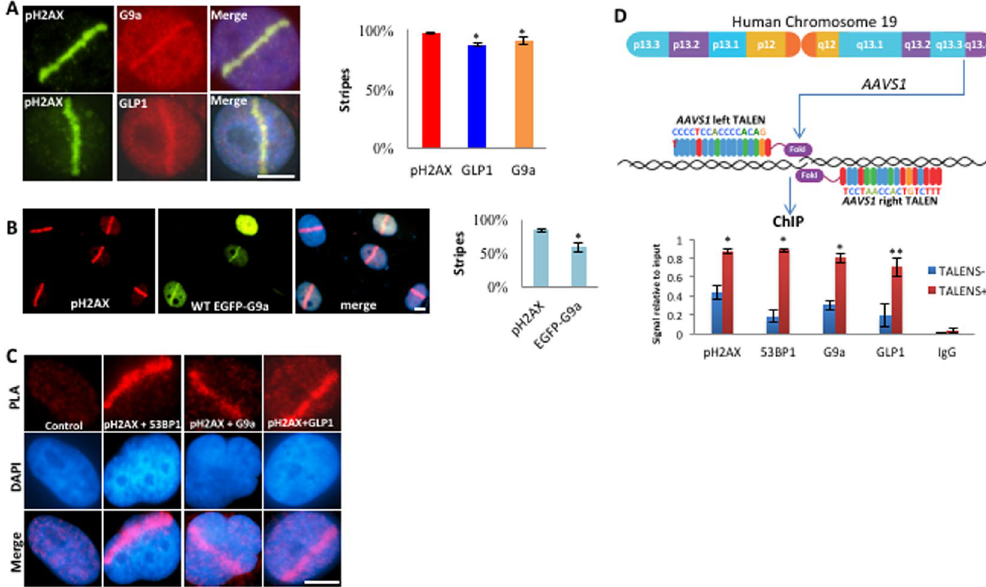
Figure 1. G9a and GLP1 accumulate at DNA-damage sites. ( A ) HeLa cells were laser micro-irradiated and after 10 minutes processed for IF staining using indicated antibodies. ( B ) HeLa cells co-transfected with GFP-G9a were micro-irradiated IF staining for H2AX and GFP signal are shown. ( C ) PLA was used to visualize regions of close proximity between γ H2AX and either 53BP1, G9a or GLP1 in U2OS cells treated with micro-irradiation. PLA using only γ H2AX antibody alone is shown as negative control. ( D ) U2OS cells were transfected with either TALEN targeting the AAVS1 site and having intact FOK1-nuclease (TALEN + ) or vectors lacking active FOK1-nuclease domains (TALEN − ) and processed for ChIP using antibodies indicated. PCR was conducted using primers in the regions flanking AAVS1 site, and signals were quantified and plotted for each condition. For panels A and B quantification of IF images are shown, plotted as % of micro-irradiated cells that were also positive for pH2AX, G9a, GLP1, and EGFP-G9a. Data represent 100micro-irradiated cells in three independent experiments and data are expressed as the mean ± SEM. ** P < 0.01, * P < 0.05. Scale bar, 5 μ